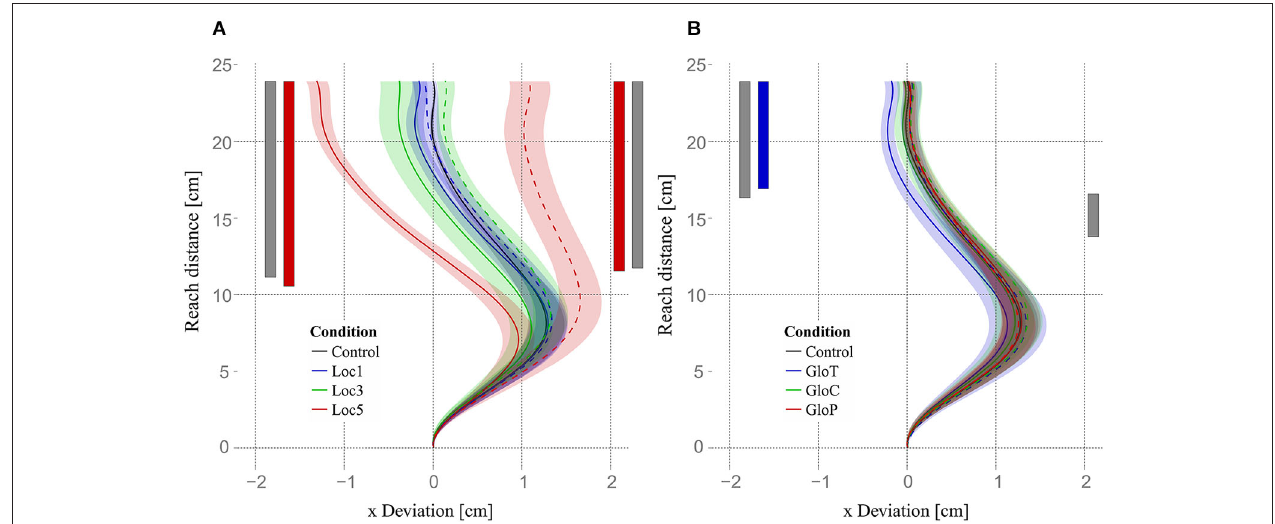
condition are displayed. Red bars indicate the area where leftward and rightward shifts of the loc5 condition significantly differed from the control condition. (B) Mean trajectories for all global conditions and the control condition. The blue bar indicates the area where leftward shifts in the gloT condition significantly differed from the control condition. Shaded areas in (A) and (B) express one standard error of the mean of the corresponding mean